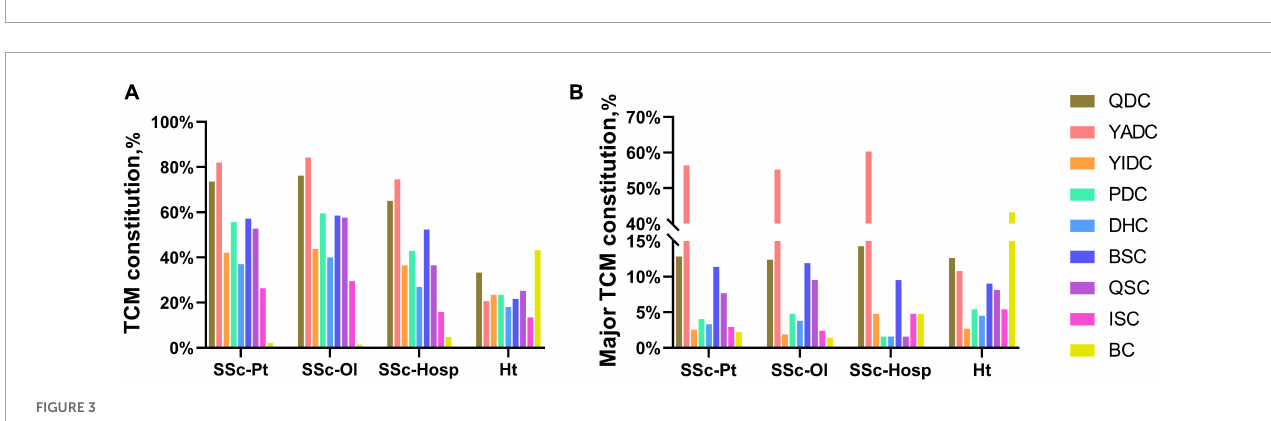
FIGURE2 Work place, income and disease condition. (A) Working place of online systemic sclerosis patients. (B) Working place of hospital systemic sclerosis patients. (C) Working place of healthy person. (D) Income of online systemic sclerosis patients. (E) Income of hospital systemic sclerosis patients. (F) Income of healthy person. (G) Disease condition of all systemic sclerosis patients. (H) Disease condition of online systemic sclerosis patients. (I) Disease condition of hospital systemic sclerosis patients. SSc-Pt, systemic sclerosis patients; SSc-Ol, online systemic sclerosis patients; SSc-Hosp, hospital systemic sclerosis patients; Ht, healthy person.